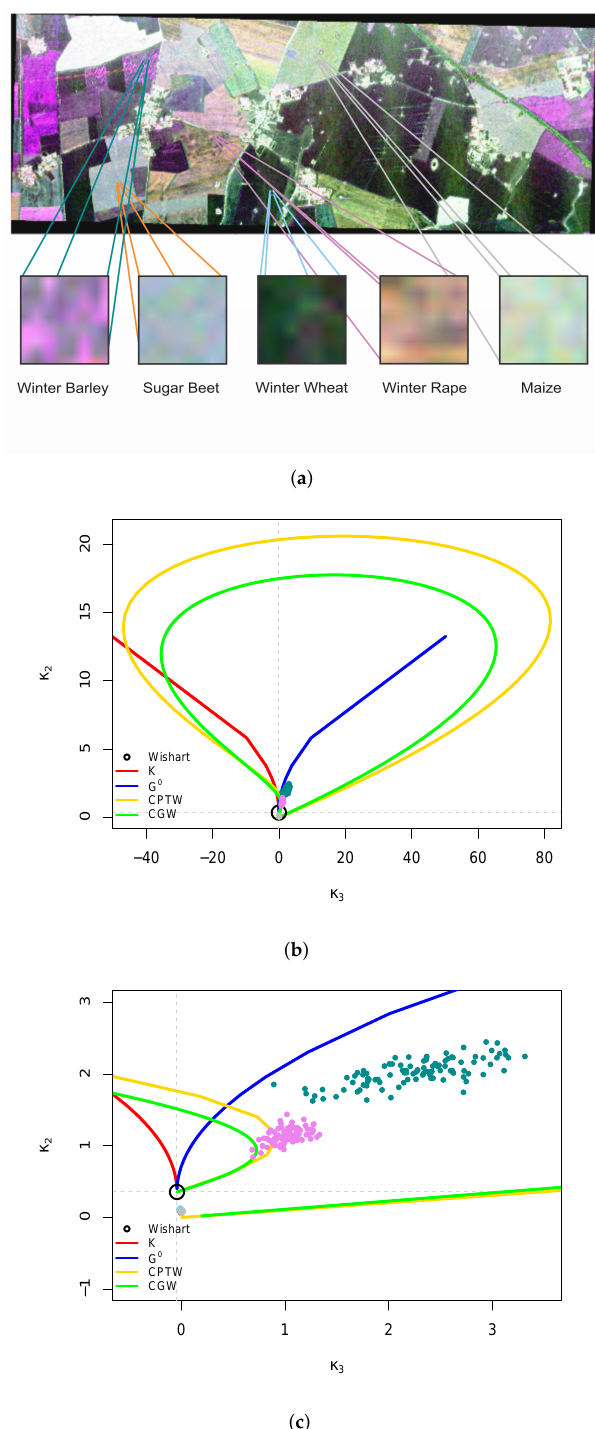
Figure 10. MLC diagram with sample MLCs computed from the samples of AgriSAR. ( a ) Subset areas of AgriSAR. ( b ) MLC diagram with sample MLCs computed from the samples in ( a ). ( c ) Zoom on the